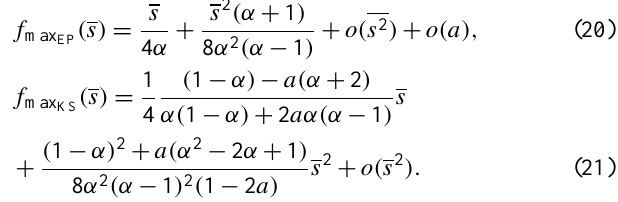
− f max in the EP KS